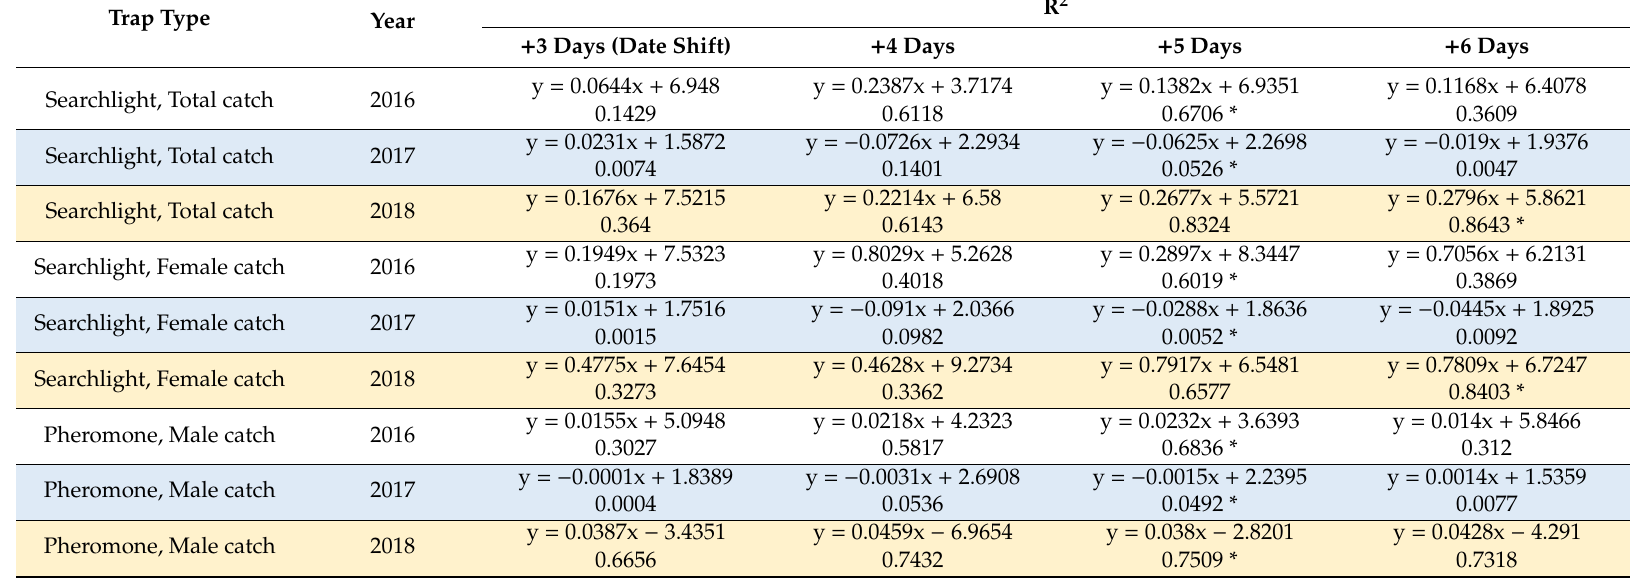
* Scatter plots of these functions are shown in Figures 5 and